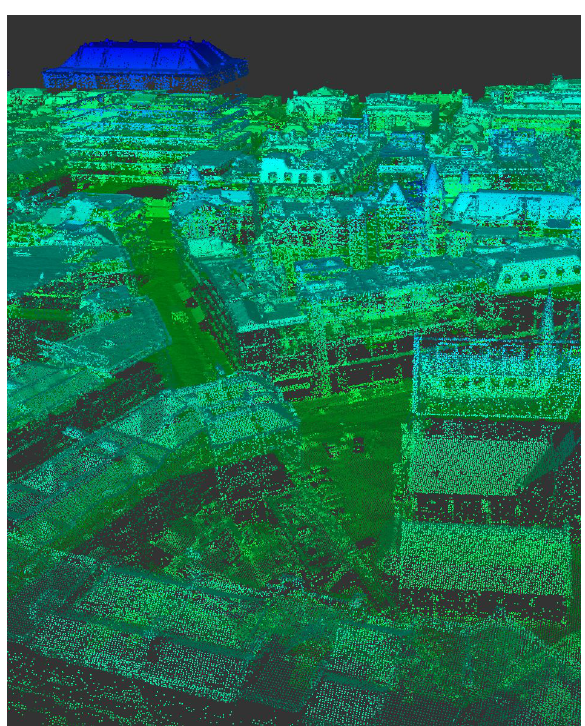
Figure 1. Laser scan of Dublin consisting of 226 million points before downsampling. The buildings and streets are clearly visible because the points were obtained from an airplane, so the point density is much higher than on the walls. Unfortunately, no RGB color information is available. Source: [1]